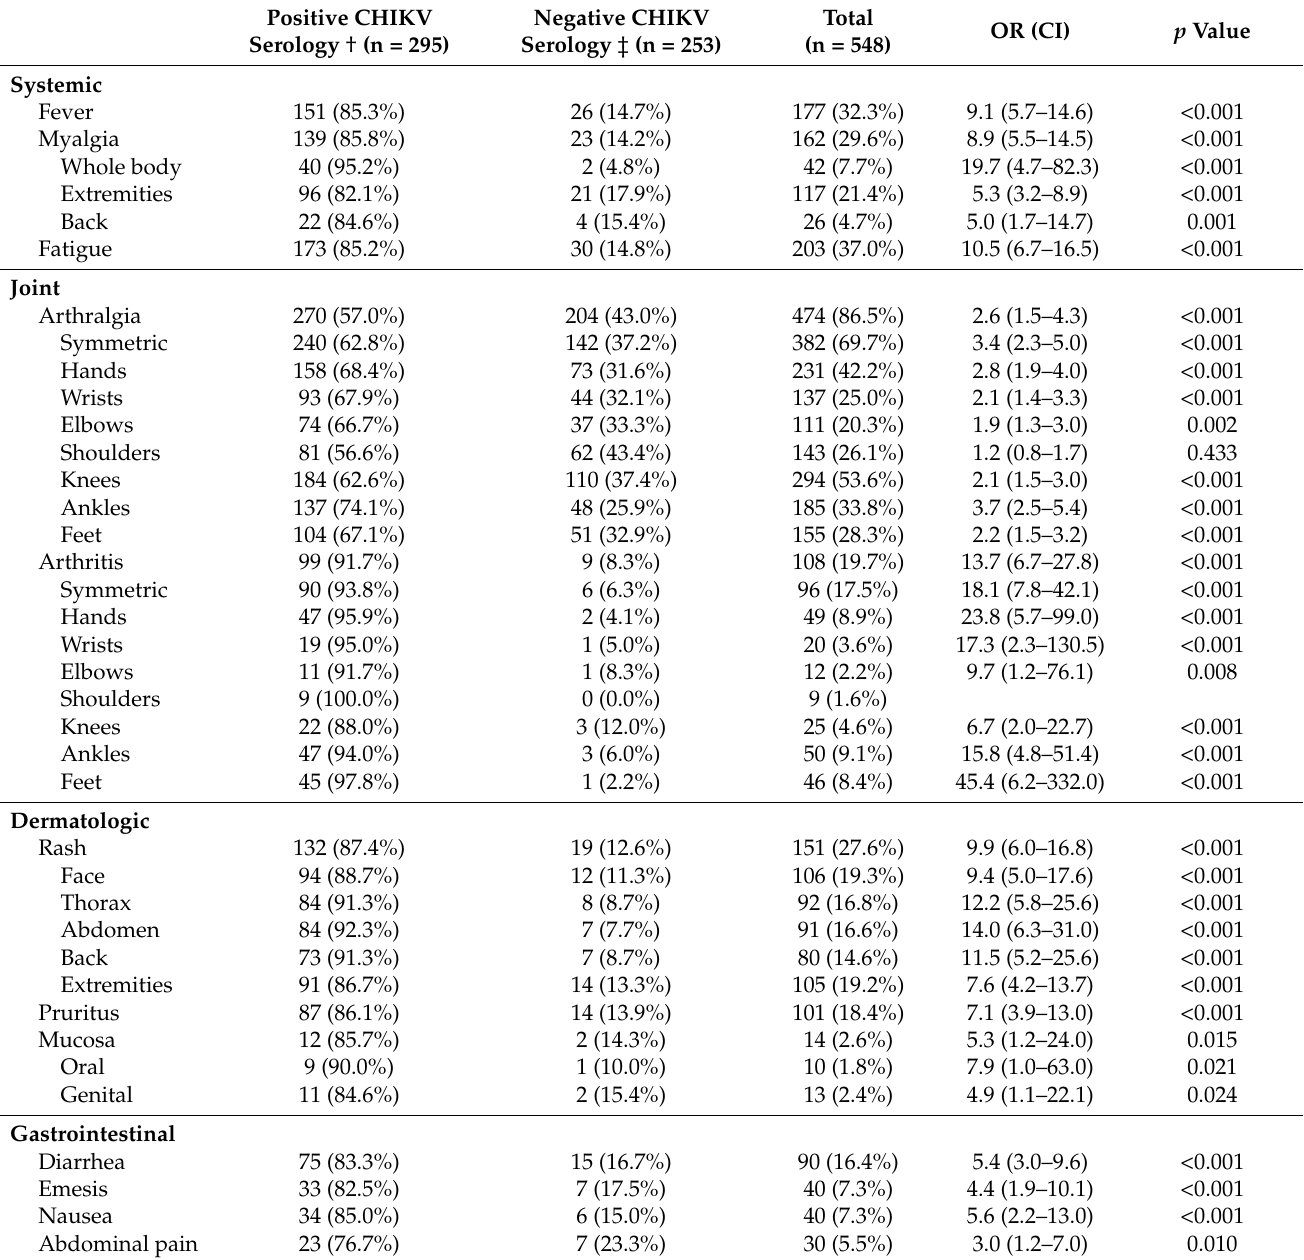
Table 2. Univariate analysis of clinical features of patients with suspected CHIKV